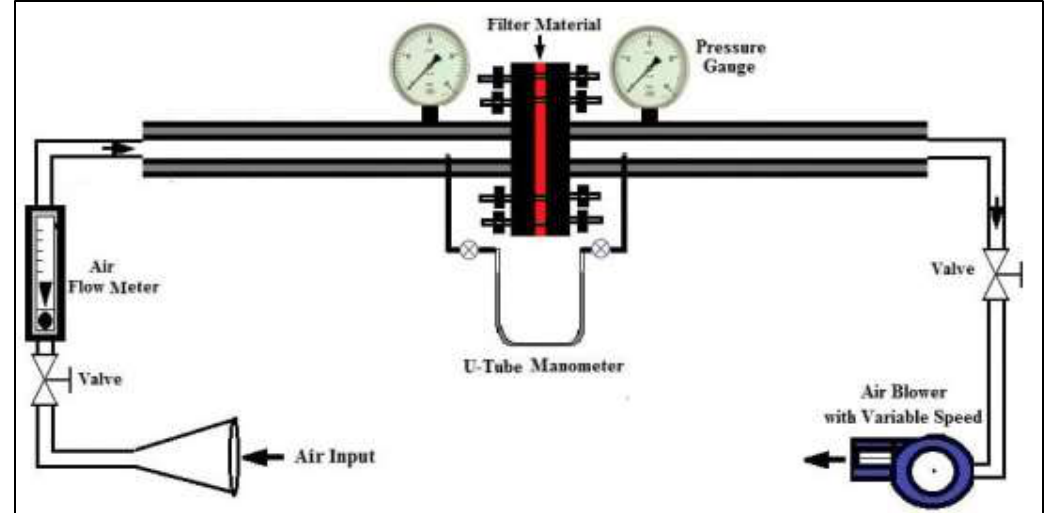
Figure 6: Schematic diagram of the air flow system.